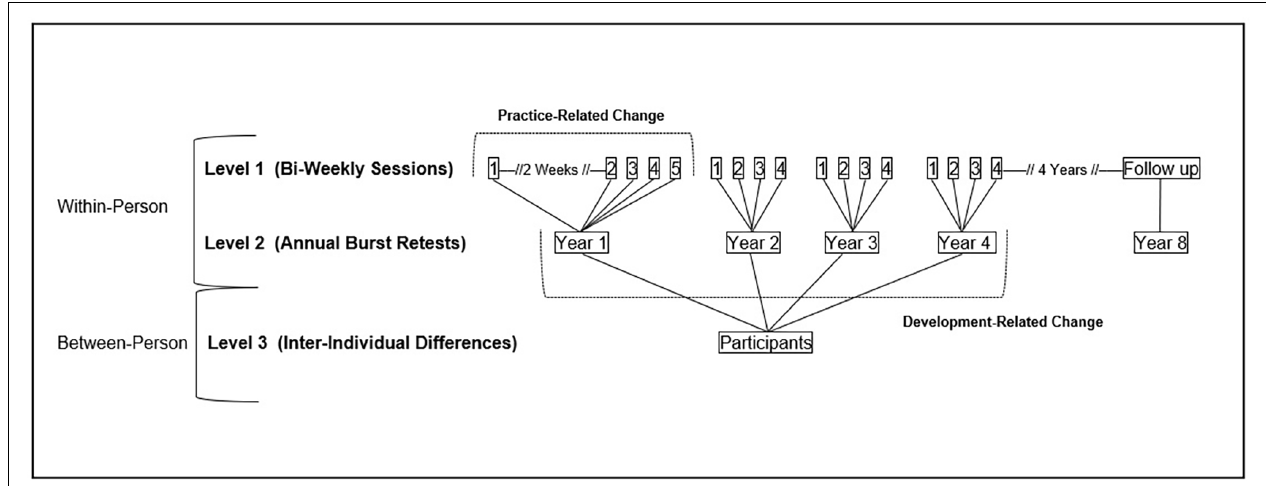
FIGURE 1 | Parameterization of retest and developmental change using three-level multilevel modeling and a measurement burst